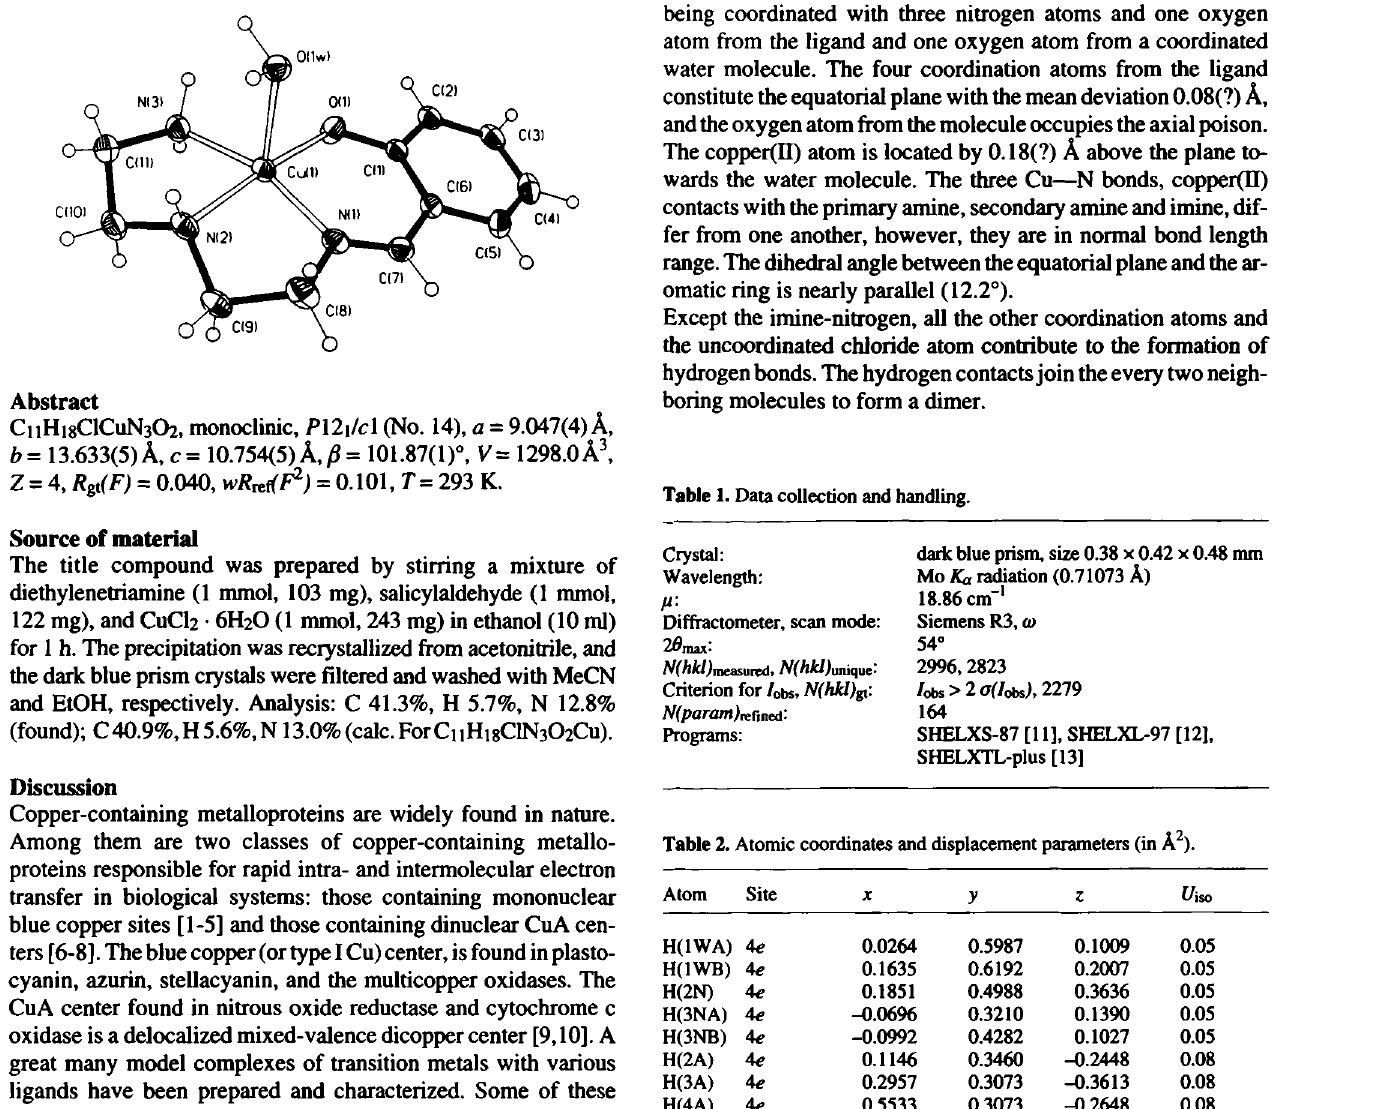
Table 2. Atomic coordinates and displacement parameters (in Â 2